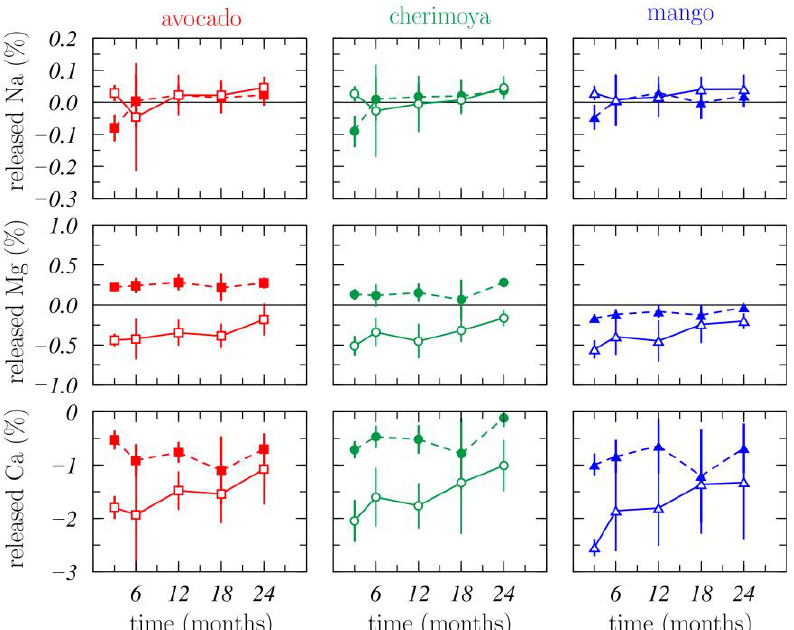
Figure 4. Release of Na, Mg, and Ca at each sampling period (3, 6, 12, 18, and 24 months). The solid line represents the concentrations of the garden waste and the broken line the concentration of the subtropical waste in the respective tree.